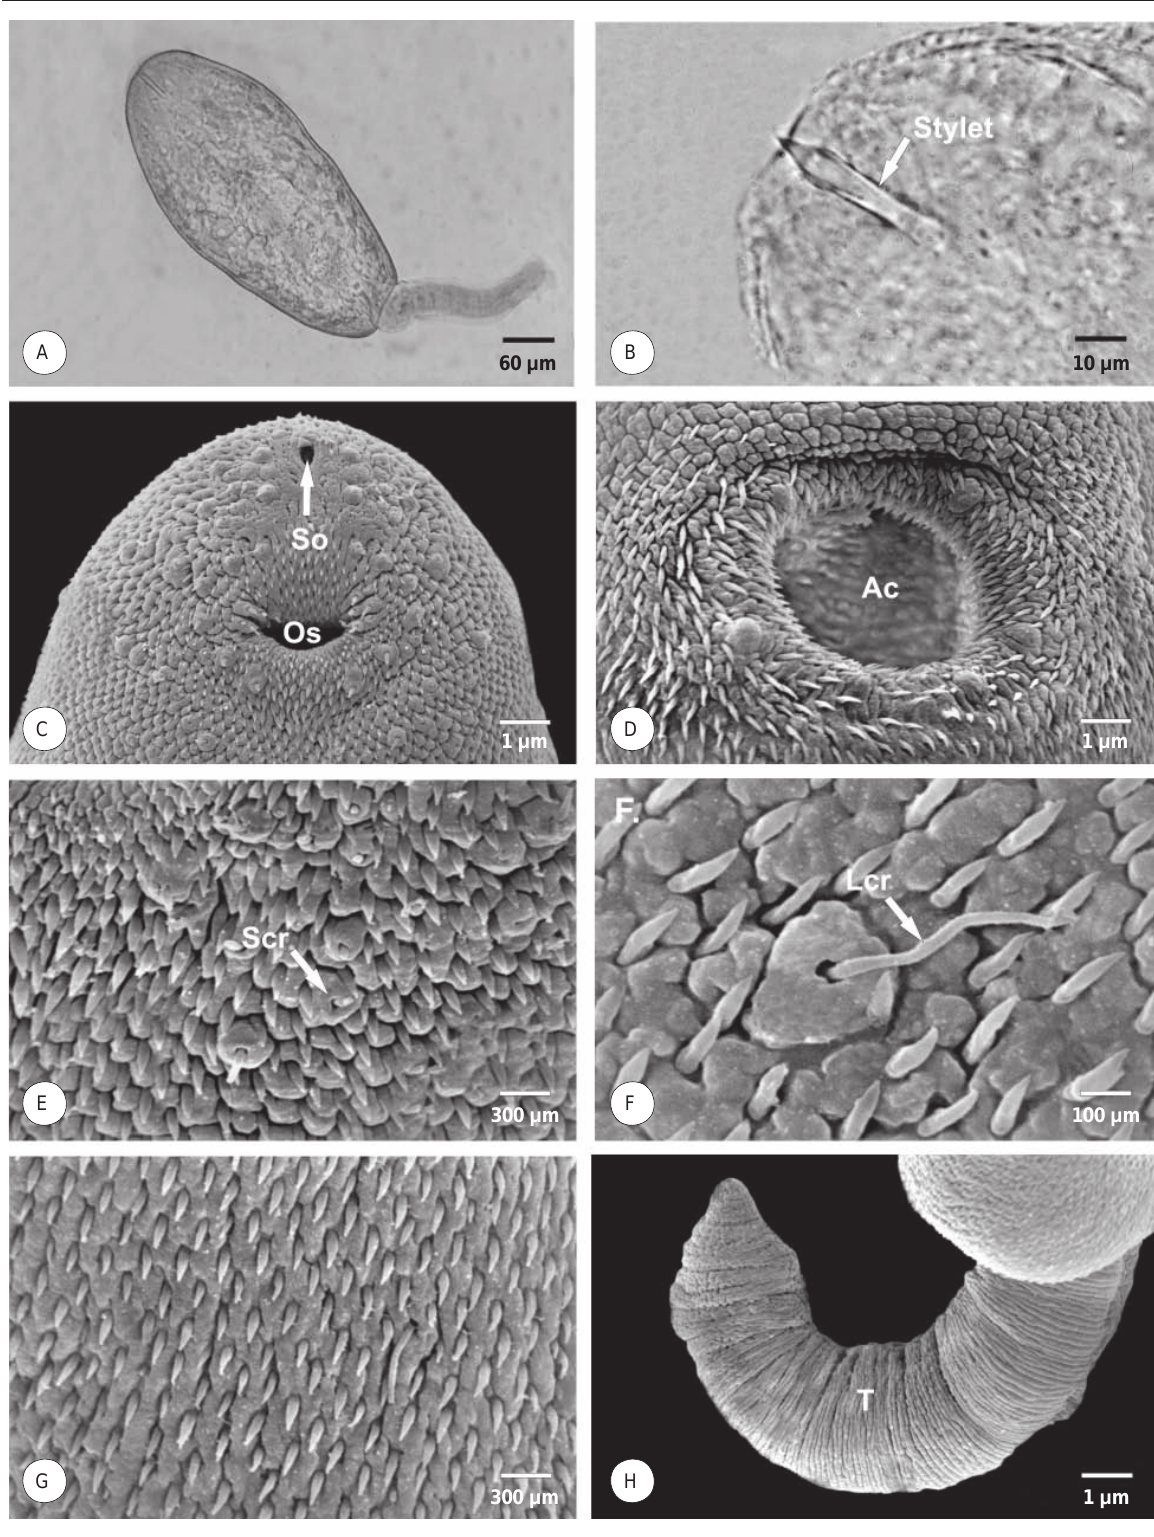
FIG. 4 Xiphidio cercaria. Light micrographs of (A) whole mount; (B) anterior stylet (S); (C–H) scanning electron micrographs of cercaria: (C) oral sucker (Os) and stylet opening (So); (D) acetabulum (Ac); (E) short ciliated receptors (Scr); (F) long ciliated receptors (Lcr); (G) tegumental features of the body; (H) tail